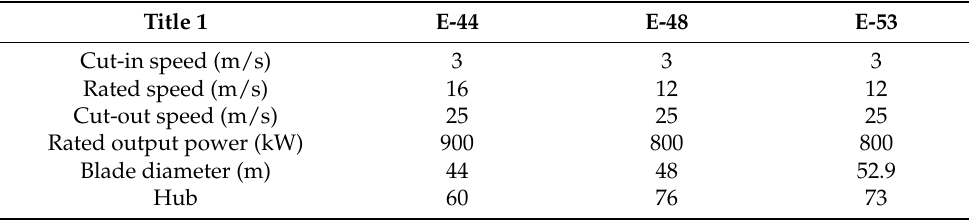
Table 2. Characteristics of wind turbines.